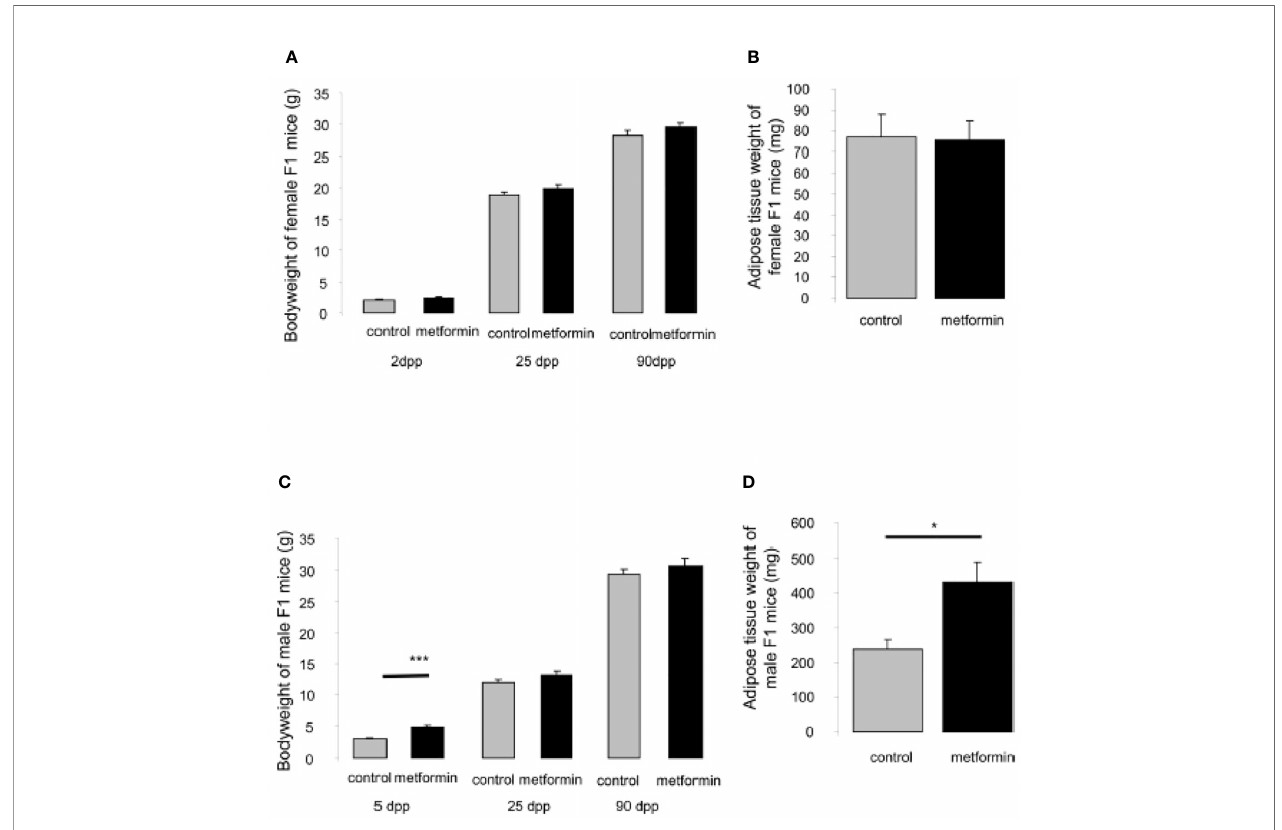
FIGURE 3 | Body and adipose tissue weight of male and female offspring exposed in utero . (A) Body weight at 2dpp, 25dpp and 90dpp of female mice exposed to metformin in utero . (B) Weight of adipose tissue of adult female mice (90dpp) exposed to metformin in utero . (C) Body weight at 5dpp, 25dpp and 90dpp of male mice exposed to metformin in utero . (D) Weight of adipose tissue of adult male mice (90dpp) exposed to metformin in utero . Values are expressed as mean ± SEM (n=5-7). *p < 0.05, ***p <